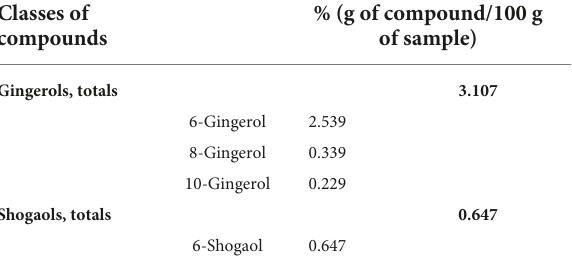
TABLE 2 Characterization of Zingiber officinale